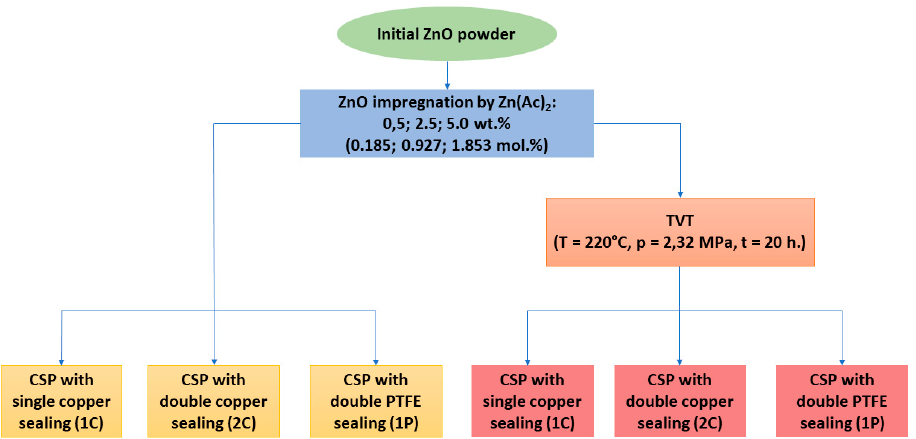
Figure 14. Scheme of ZnO powder preparation and cold sintering process